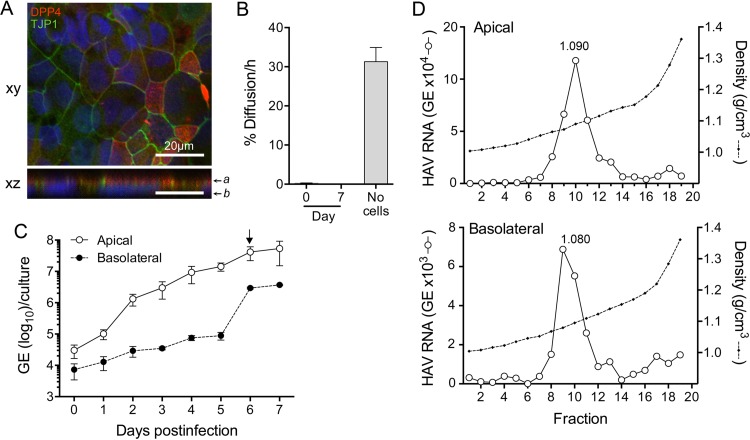
HAV infection of polarized Caco-2 cell monolayers. (A) Polarity was assessed by determining the intracellular localization of DPP4 (CD26) and TJP1 (ZO-1). Cells were seeded into chamber slides and cultured for 10 days before being fixed and stained with antibodies specific for DPP4 (red) and TJP1 (green). Nuclei were counterstained with DAPI (blue). Images of xy and xz sections were collected by confocal microscopy. z sections were compiled by taking 0.41-μm steps through each x-y section; “a” and “b” indicate approximate positions of apical and basolateral membranes, respectively. The scale bars represent 20 μm. (B) The integrity of monolayer cell cultures grown on Transwell membranes was assessed by measuring paracelluar diffusion of FITC-dextran prior to (day 0) and 7 days after virus infection. Results shown represent the mean percentage ± range of FITC-dextran delivered to the apical chamber that was detected in the basolateral chamber 60 min later (see Materials and Methods). (C) Vectorial release of quasi-enveloped HAV from polarized Caco-2 cells. After 14 days of culture on Transwell inserts, cells were infected by inoculating the apical surface with HAV. Total apical and basolateral fluids were collected at 24-h intervals, and HAV RNA was quantified by RT-qPCR. (D) The buoyant density of virus particles present in the apical (top) and basolateral (bottom) compartments of Transwell cultures on day 6 of the infection was determined by centrifugation in isopycnic iodixanol gradients followed by HAV-specific RT-qPCR.